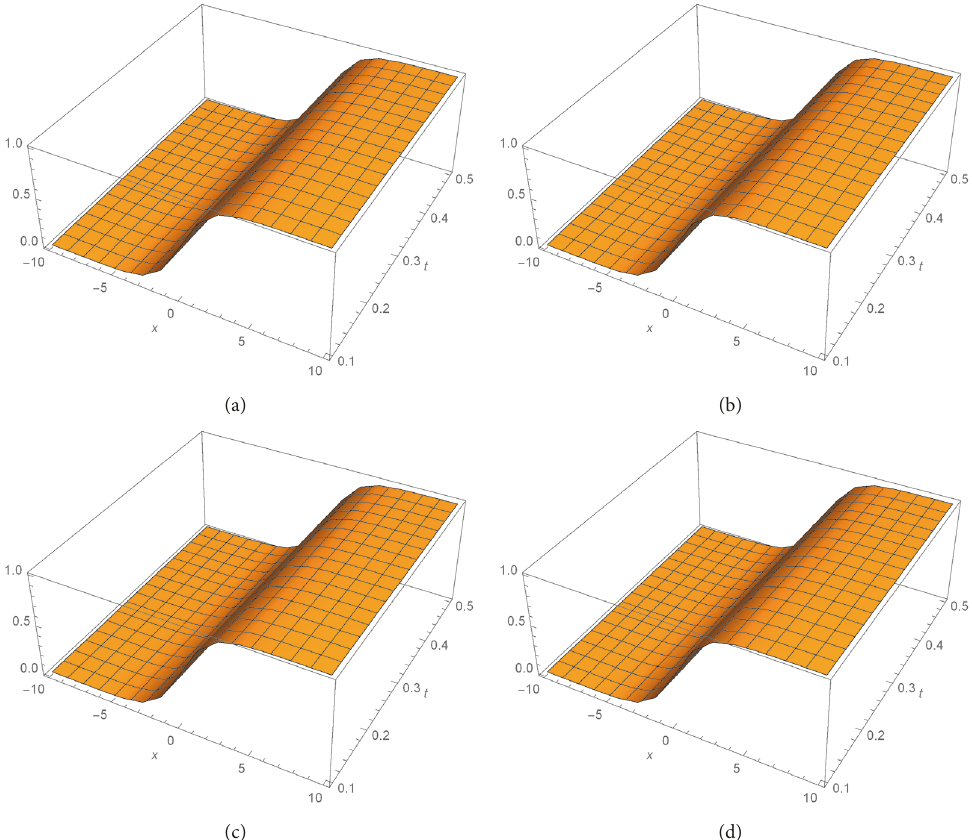
Figure 3: The approximate solution for fractional Gardner equation at 𝜀 = 1 : (a) 𝛼 = 1 , (b) Exact solution, (c) 𝛼 = .99 , and (d) 𝛼 = .95